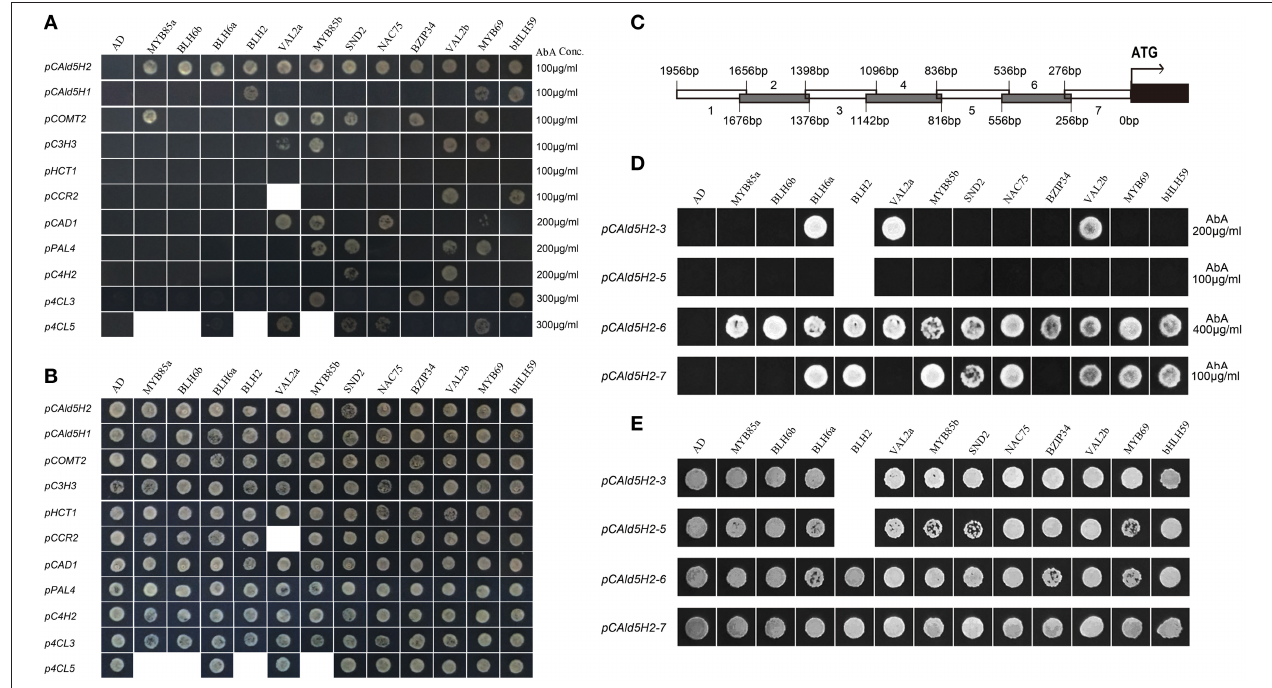
FIGURE 2 | Yeast one hybridization. (A,B) Yeast one-hybrid (Y1H) of 12 transcription factors (TFs) with 11 monolignol pathway genes in Populus trichocarpa . TF-prey plasmids were transformed into bait strains and grown on SD/-ura-leu. We did not obtain transformants for VAL2a transformed into CCR2 promoter strain, and for MYB85a , BLH6b , BLH2 , and MYB85b transformed into 4CL5 promoter strain (B) . The transformants were selected on SD/-ura-leu + AbA (A) . The concentrations of Aureobasidin A (AbA) are shown on right. (C–E) Y1H of 12 TFs with seven fragments of CAld5H2 promoter in P. trichocarpa . (C) The 2kb P. trichocarpa